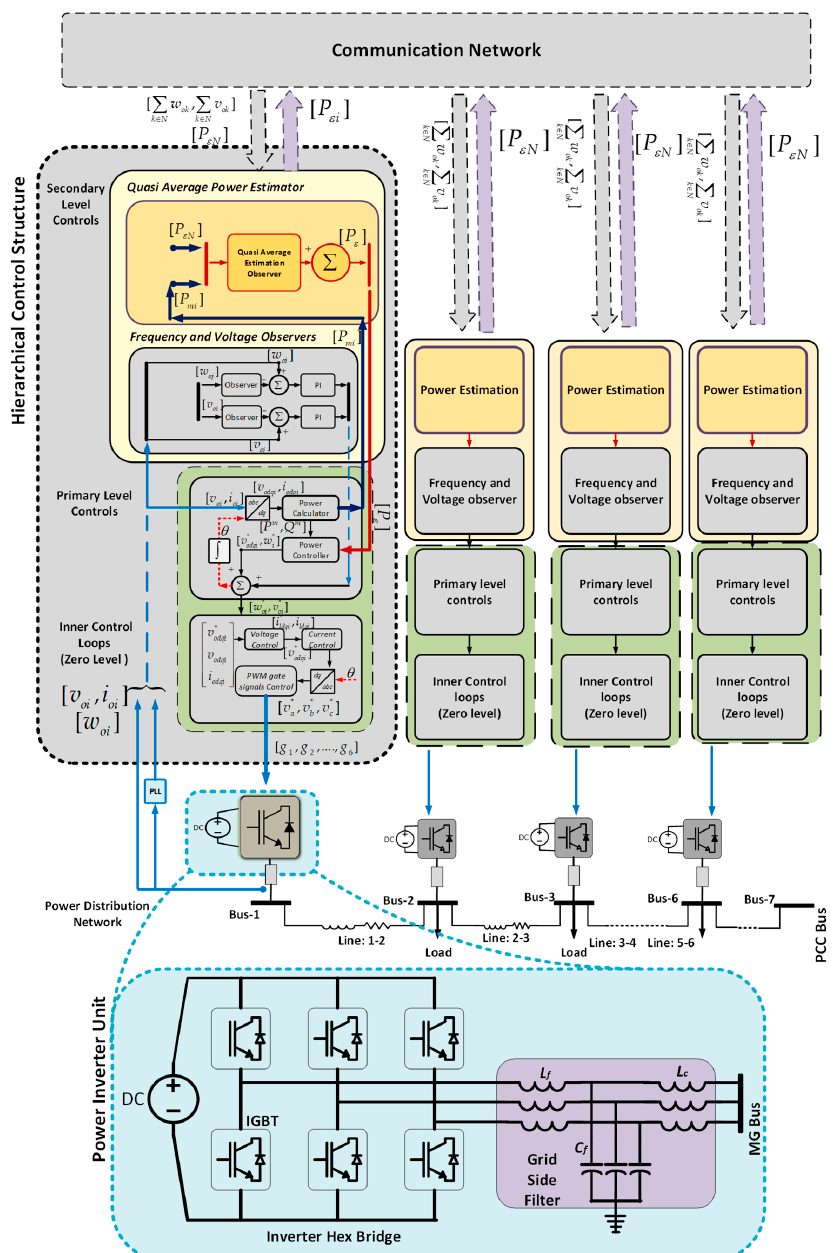
Figure 1. Power distribution network and proposed hierarchical control.